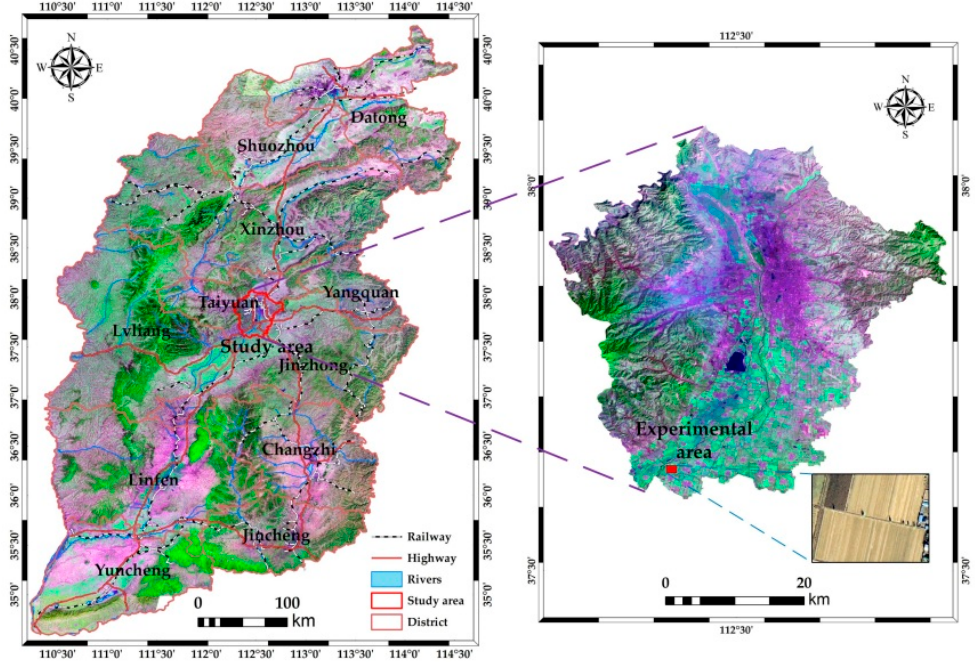
Figure 1. Geographical location of the study area.